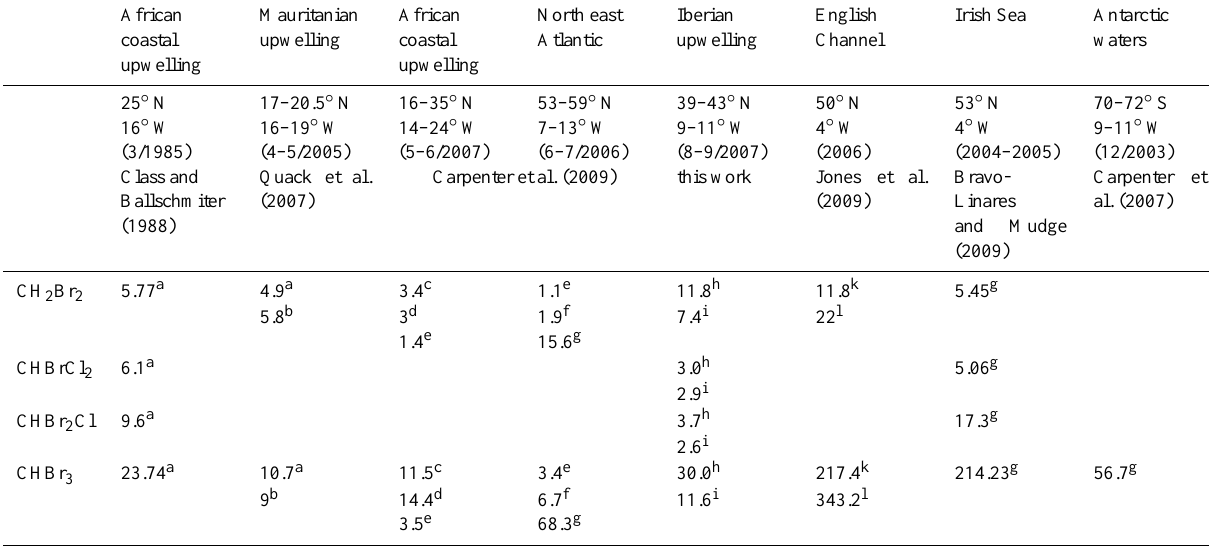
Table 2. Comparison of bromocarbon concentrations in different marine regions. Mean values in pmoll − 1 . African coastal